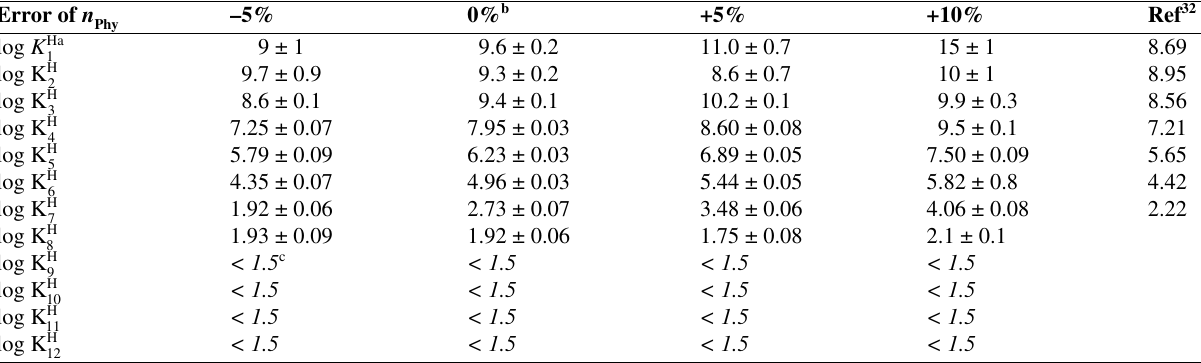
Table 1. Apparent protonation constants with calculated standard deviations of phytate in 1.0 M NaCl at T = 298 K, calculated from experimental data shown in Fig. 5 (a) using different deviations from the actual amount of phytate present in titration cell and comparison with literature. Error of n –5% 0% b +5% +10% Ref 32 Phy log K H 1a